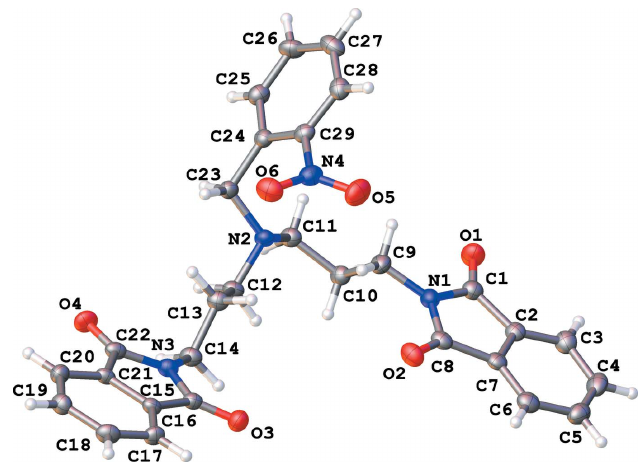
Figure 1 The molecular structure of the title compound, showing 50% probability ellipsoids.